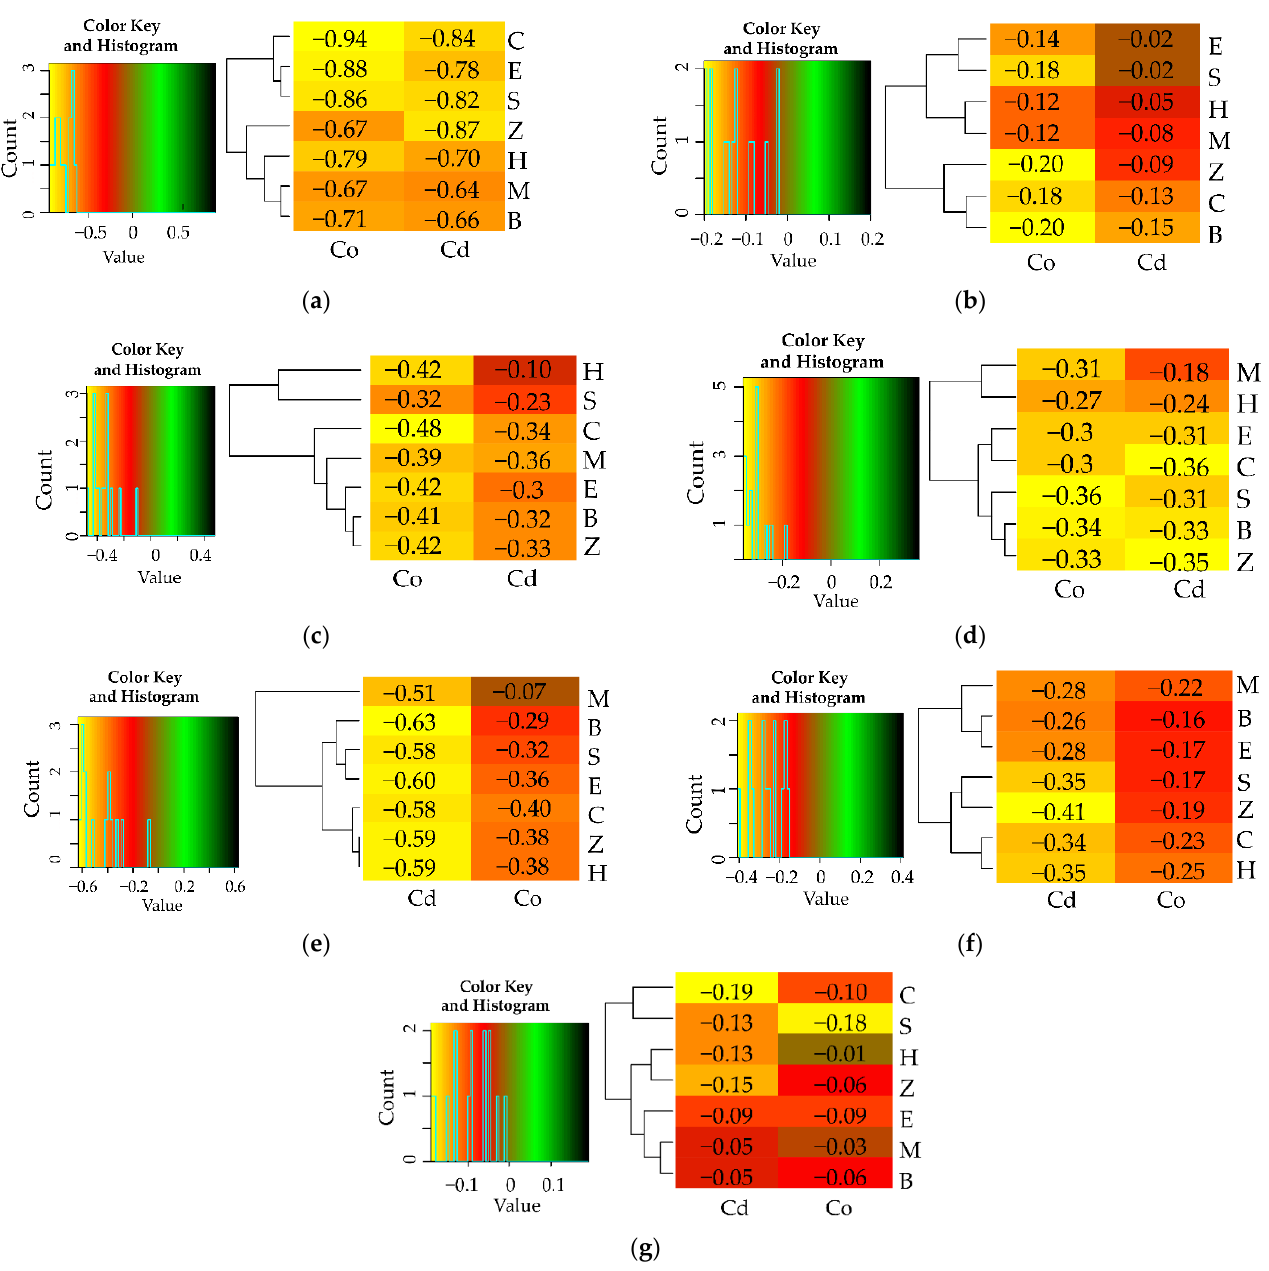
Figure 4. Indexes of the influence of heavy metals on the activity of enzymes (IF Hm ). ( a ) dehydrogenases (Deh), ( b ) catalase (Cat), ( c ) urease (Ure), ( d ) acid phosphatase (Pac), ( e ) alkaline phosphatase (Pal), ( f ) arylsulfatase (Aryl), ( g ) β -glucosidase (Glu). M—molecular sieve, H—halloysite,